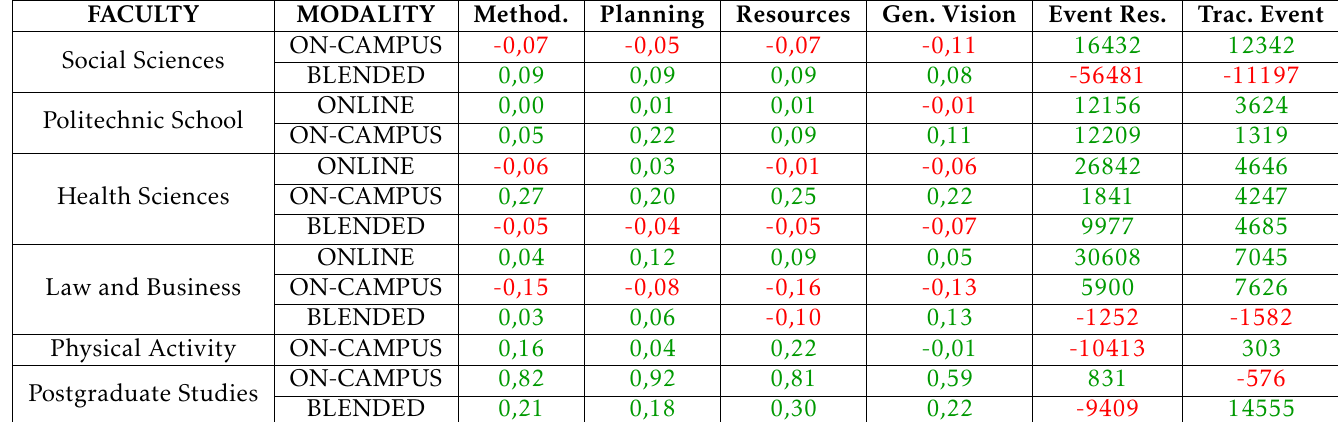
Table 2. Comparative between the results of the students’ assessment of lecturer’ methodologies and Sakai events generated by